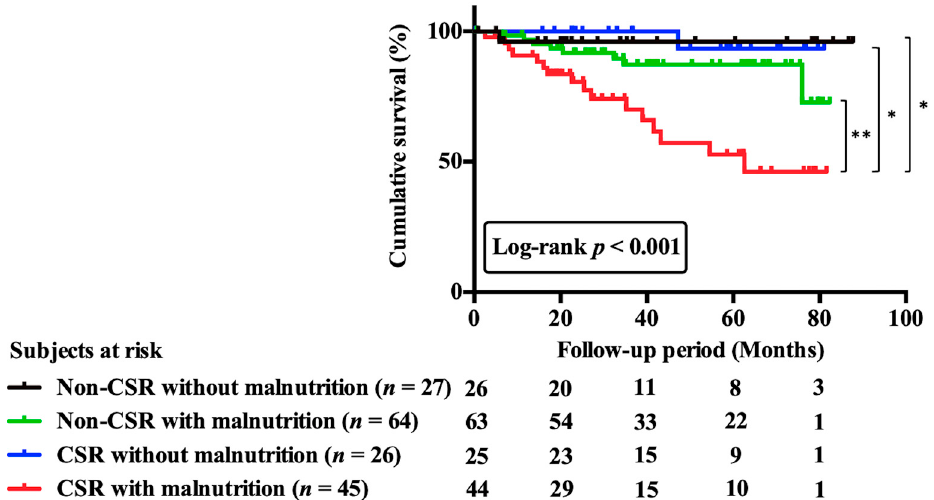
Figure 4. Cumulative survival curves across 4 groups including patients with and without CSR or malnutrition. Patients were categorized into four groups on the basis of prevalence or absence of CSR and of presence or absence of malnutrition. Cumulative survival curves across 4 groups were significantly different. Abbreviations: CSR, Cheyne-stokes respiration. * p < 0.05; ** p < 0.01. Table 2. Univariate and Multivariate Cox regression analysis on all-cause mortality.